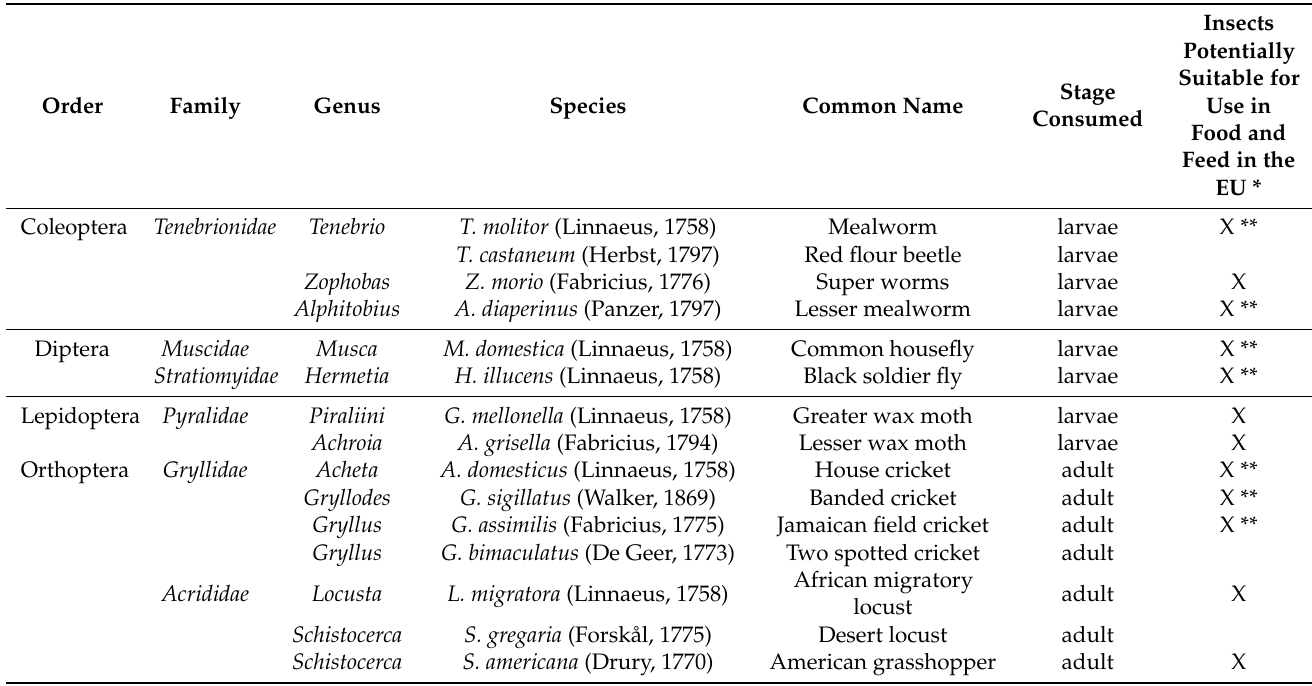
Table 1. List of edible insect species considered in this review.